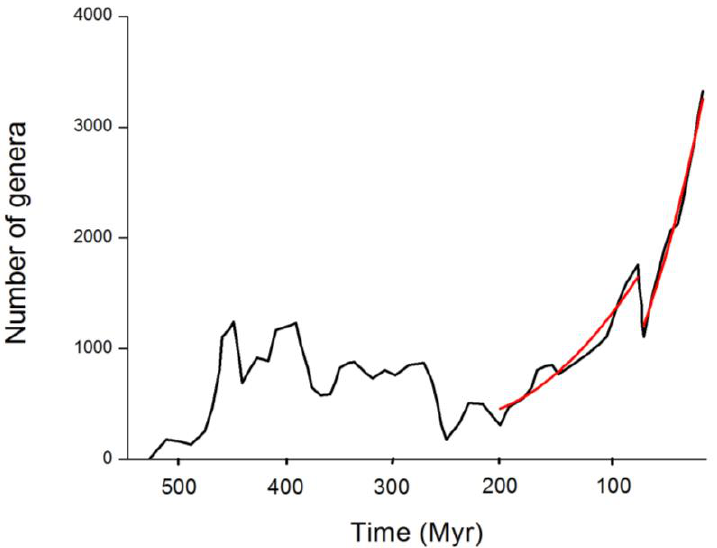
Figure 1. Best fits to the long-term recovery after the Triassic-Jurassic (left red segment) and Cretaceous-Paleogene (right red segment) extinctions. The black curve is the data by Sepkoski [22], which suggests a more dramatic growth for the latter and overall for 𝑁 The model performs well within a quadratic evolution steaming from the solutions of (𝑑 2 𝑁 /𝑑𝑡 2 ) = 𝑐𝑜𝑛𝑠𝑡𝑎𝑛𝑡 𝐺